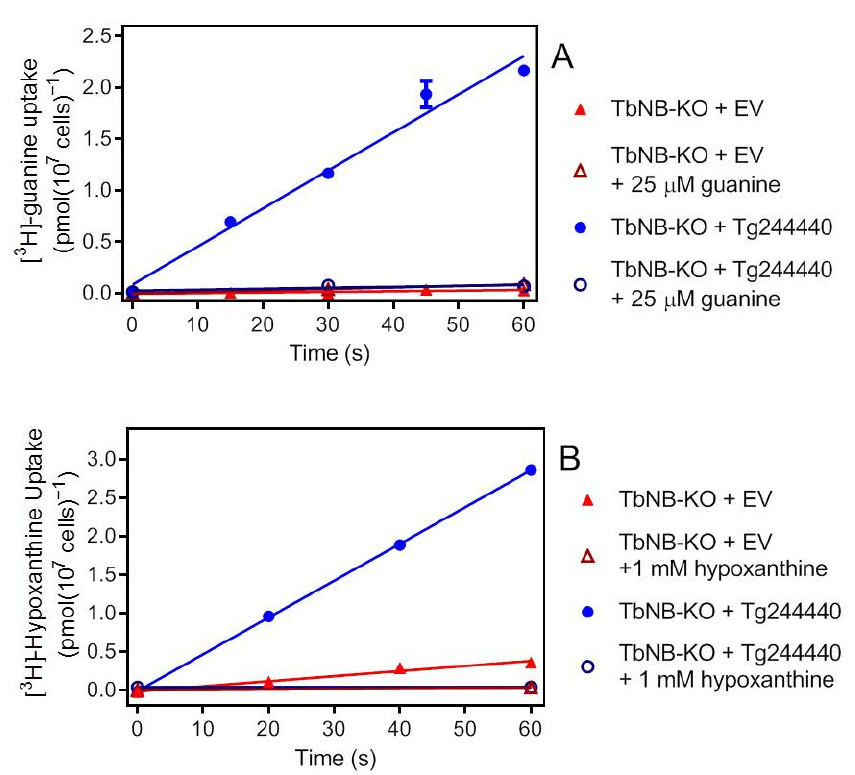
Figure 3. Uptake of oxopurine nucleobases by Tg244440 expressed in T. brucei NB-KO procyclics. ( A ) Uptake of 0.05 µ M [ 3 H]-guanine over 60 s. The rate of uptake in the cells expressing Tg244440 was 0.037 pmol(10 7 cells) − 1 s − 1 and 0.00059 in the EV control. Both rates were not significantly non-linear ( p > 0.90, runs test); uptake in the control was not significantly non-zero ( p = 0.11, F-test), whereas the rate in +Tg244440 cells was significantly non-zero ( p = 0.0012), but not in the presence of 25 µ M unlabelled guanine ( p = 0.40). ( B ) Uptake of 0.10 µ M [ 3 H]-hypoxanthine over 60 s. Rate was 0.0066 and 0.048 pmol(10 7 cells) − 1 s − 1 for EV control and +Tg2444440 cells, respectively. Both lines were not significantly non-linear ( p > 0.99) and significantly non-zero ( p = 0.012 and p < 0.0001, respectively). Each symbol represents the average and SEM of triplicate determinations.